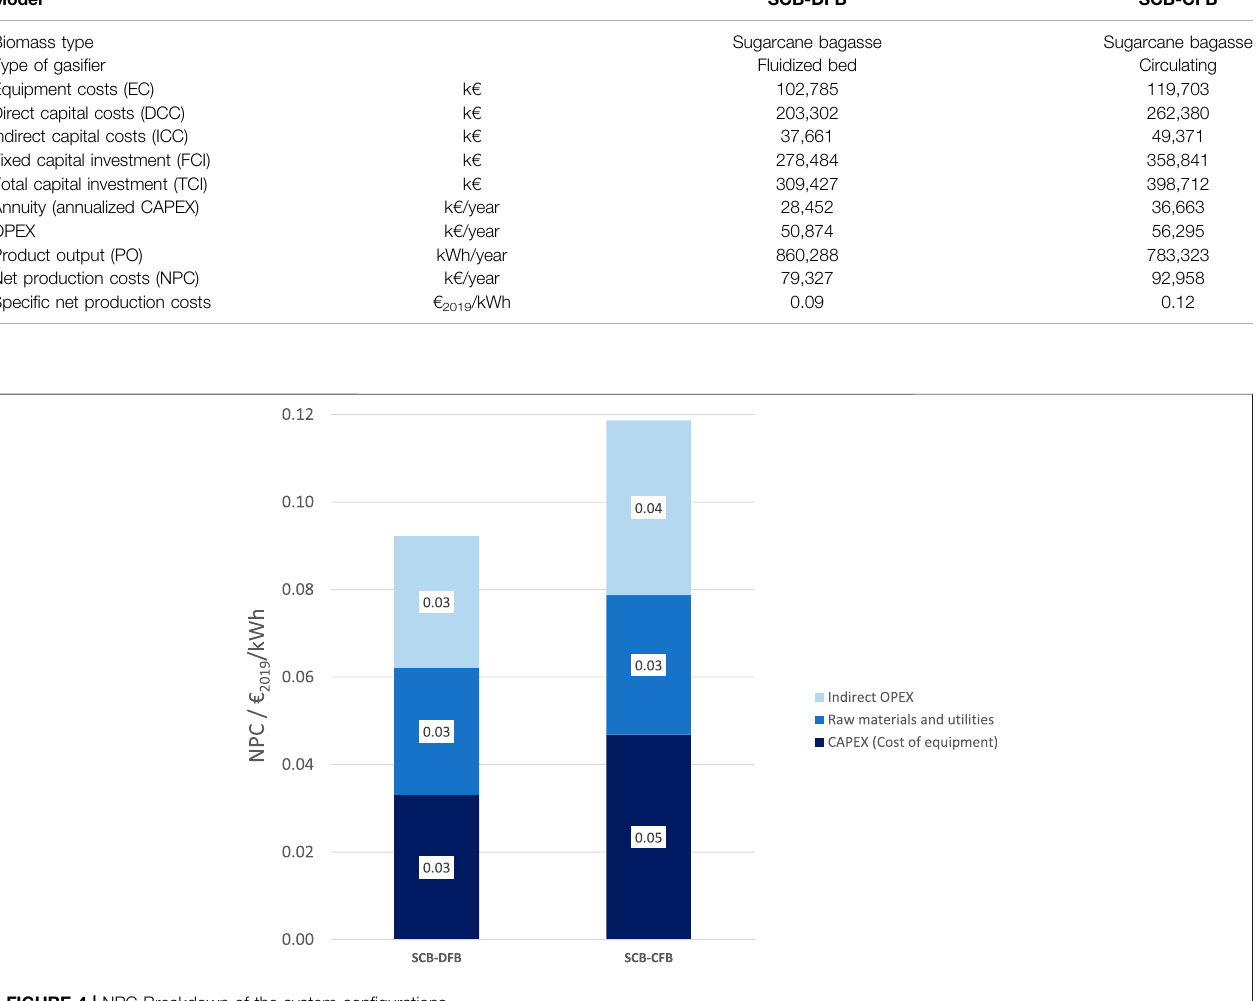
FIGURE 4 | NPC Breakdown of the system con fi